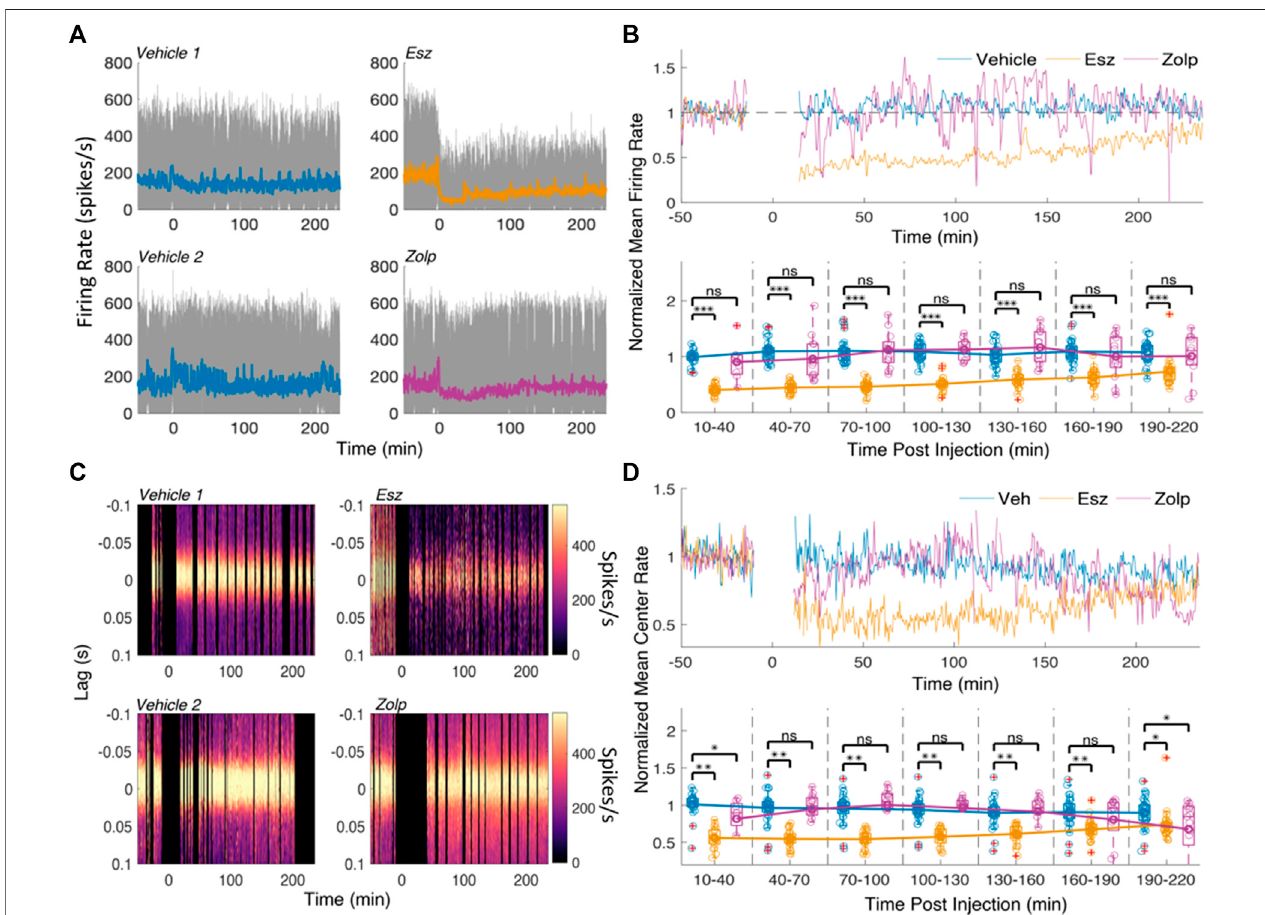
FIGURE3| Spikeratedecreasesfollowingeszopicloneanddoesnotchangesigni fi cantlywithzolpidem. (A) Multi-unit(MUA) fi ringratesforapairofvehicleandeszopiclone sessions (top) ,andapairofvehicleandzolpidemsessions (bottom) fromthesamerat.Colorlineshowsthemeanrateovertime. (B) Top:average fi ringrateacrossallsessions ( n (cid:1) 4; see Supplementary Table S2 for details), normalized by the mean baseline activity; spiking near injection ( t (cid:1) 0) was ignored. Bottom: Boxplots of the normalized mean ratesin30-minutetimeintervalspost-injectionwithlineconnectingthemeansofeachdrugtype(eachcirclecorrespondstothespikerateinoneCA1electrode;redcrosses indicateoutliers).Signi fi cancewasdeterminedusinganF-testona fi ttedmixedlinearmodel. (C) Examplesofperi-ripplehistogramsoftheMUAspikesovertimeforapairofvehicle andeszopiclonesessions (top) andapairofvehicleandzolpidemsessions (bottom) .Lag0correspondstorippleeventsand color schemeshowsthespikerate.Black vertical areasindicateperiodswithnosleepandthe10minutesaroundinjection. (D) Top:MeanMUAspikerateatthecenter(40msaroundlag0)oftheperi-ripplehistograms,normalized by the average baseline activity, across all sessions; bottom: boxplots showing individual sessions in 30 min bins post-injection with lines connecting the means (each circle one tetrode). Signi fi cance was determined using an F-test on a fi tted mixed linear